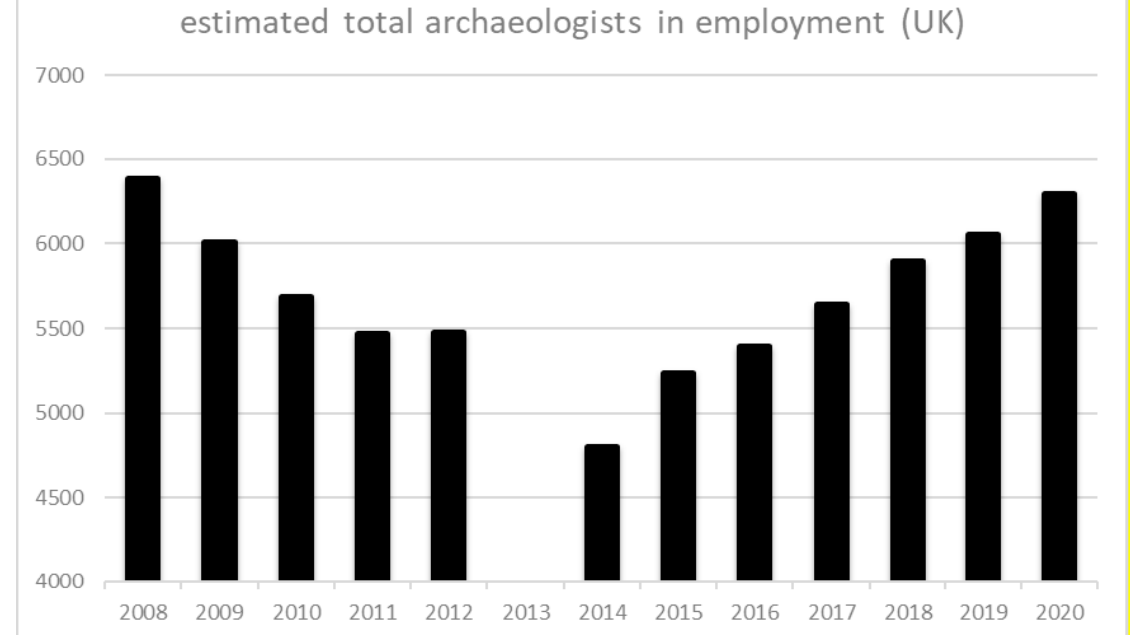
Figure 1: Estimated total numbers of archaeologists employed in the United Kingdom